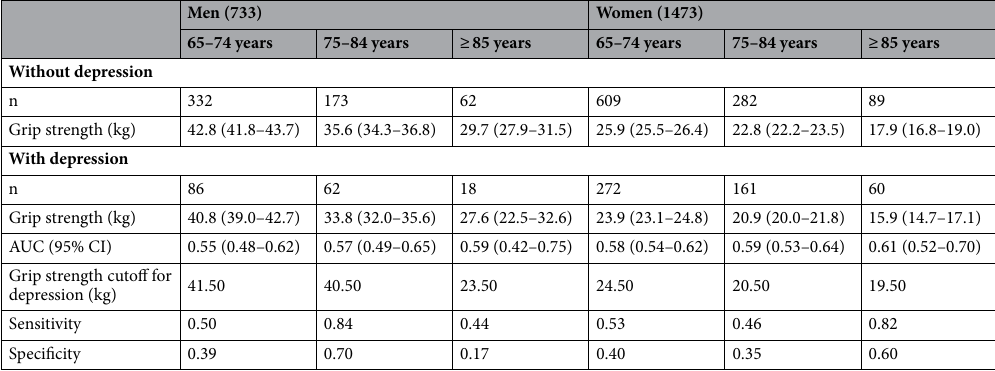
Table 2. Receiver operating characteristic for handgrip strength as an indicator of not having depression. AUC area under the